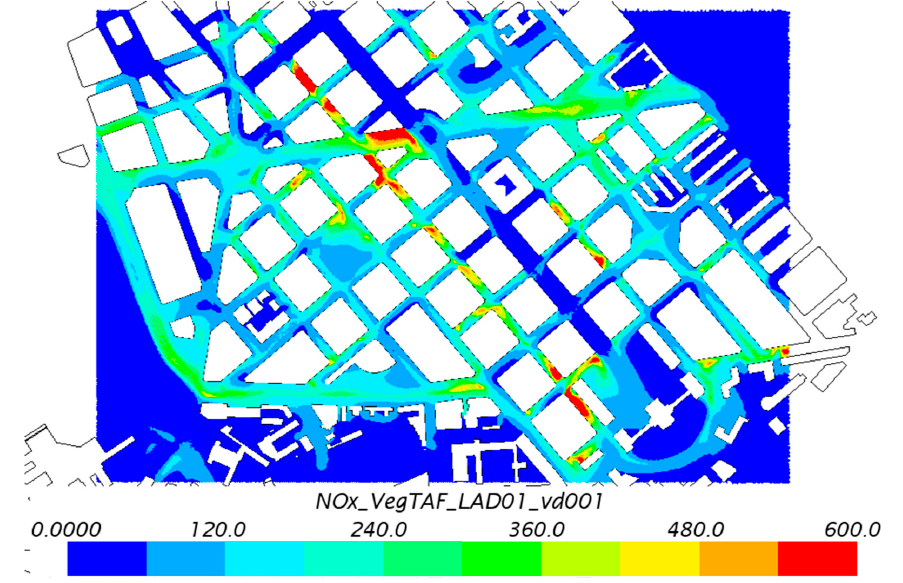
Figure 9. NO x concentration map for New-1c case.